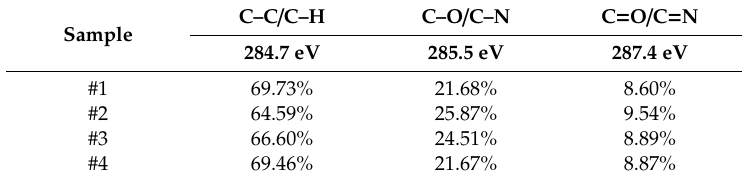
Table 4. Bonding state content of the C element of each carbonaceous deposit layer.